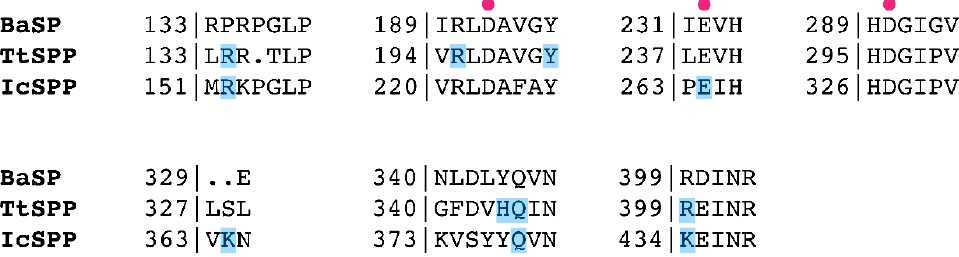
Figure 3. Differences in domains B (yellow) and B’ (teal) of ( a ) BaSP, ( b ) TtSPP, and ( c ) IcSPP. The C-terminal domain is shown in red, loop A within domain B’ is shown in black. Schematic secondary structure topology diagrams for loop B and B’ are shown left and right of the structure, respectively.